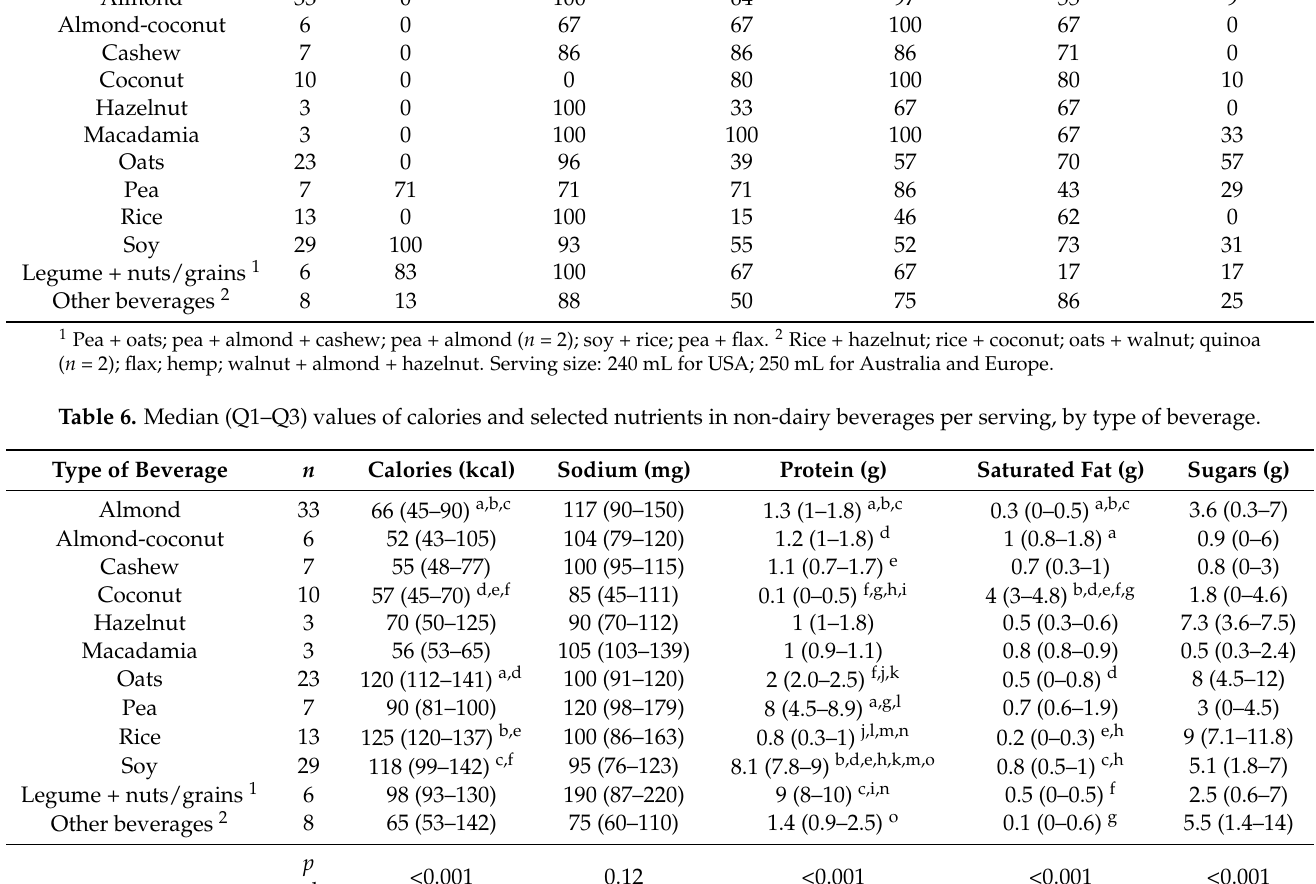
Type of Beverage Almond Almond-coconut Coconut